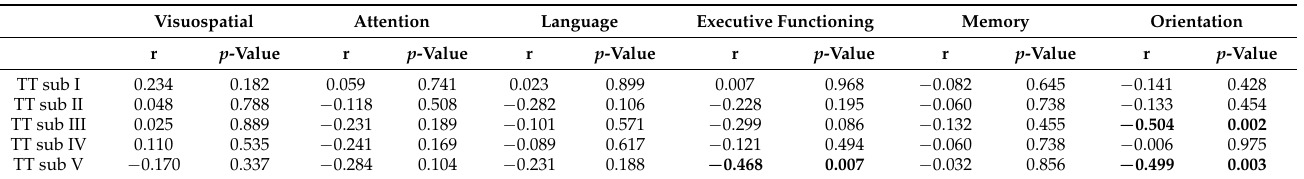
Table 4. Partial correlations between Token Test errors and Montreal Cognitive Assessment (MoCA) domains, adjusted by age.